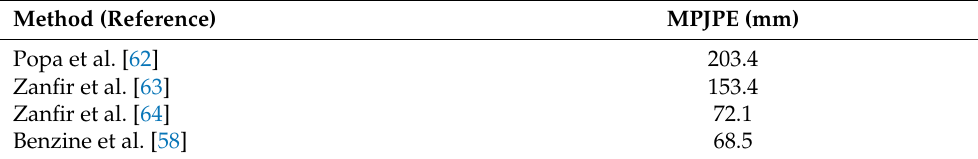
Table 2. Mean per-joint position error (MPJPE) for state-of-the-art approaches on the PAN dataset.